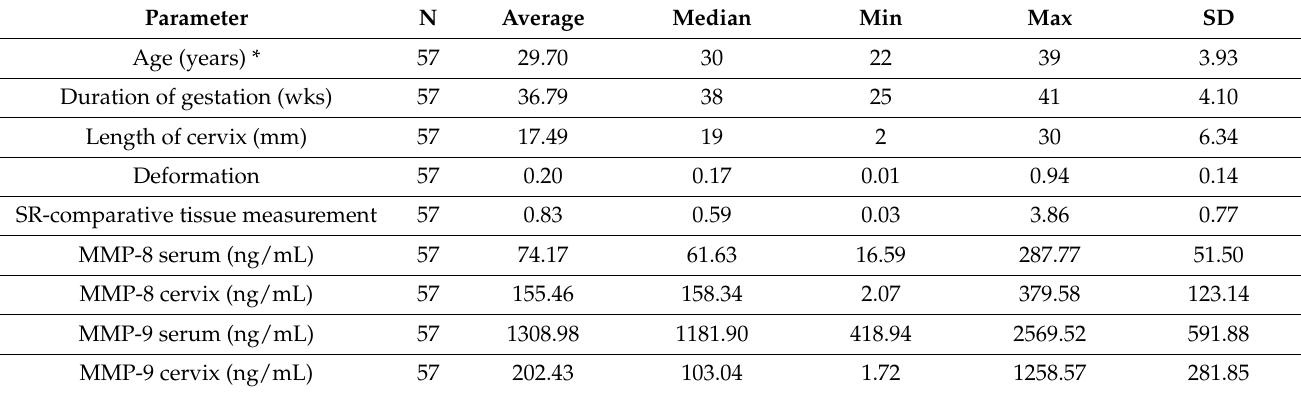
Table 2. Detailed characteristics of the study group in terms of selected demographic and clinical parameters.